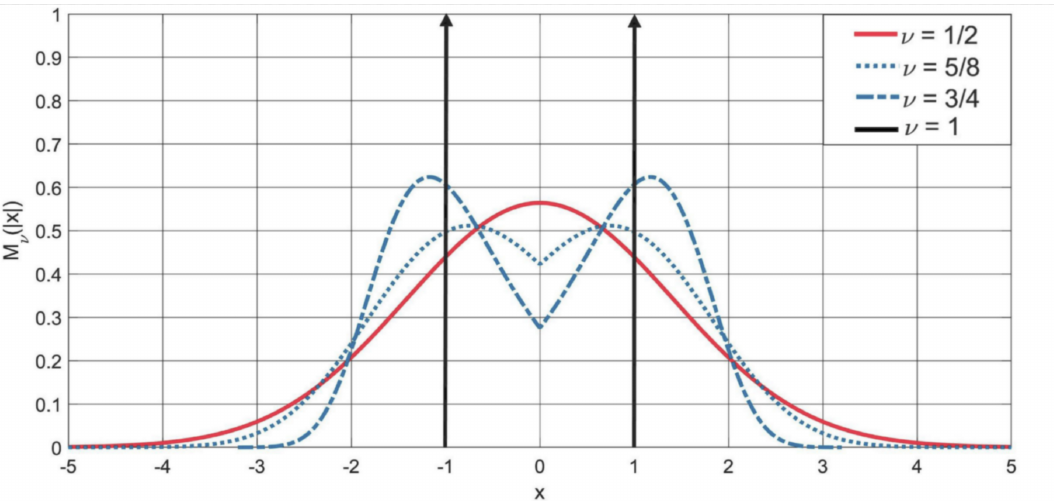
Figure 6. Plot of the symmetric M -Wright type function M ν ( | x | ) | for 1/2 ≤ ν ≤ 1. Note that the M -Wright function becomes a a sum of two delta functions centered in x = ± 1 for ν =